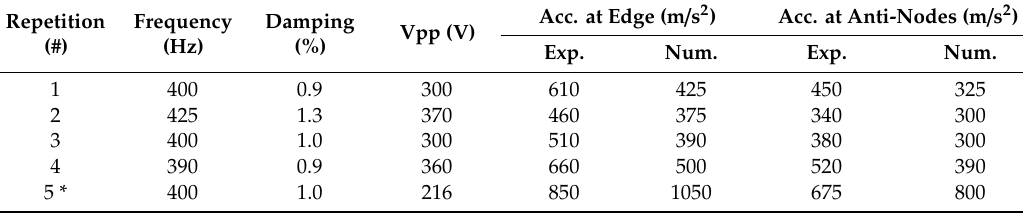
Figure 8. Acceleration (m / s 2 ) predicted by the numerical model for mode 5 (frequency in Hz) with damping of repetition 2 at edge of the plate (blue curve), at 11 cm (red curve) and center of the plate (yellow curve). Table 4. Results of test repetitions for mode